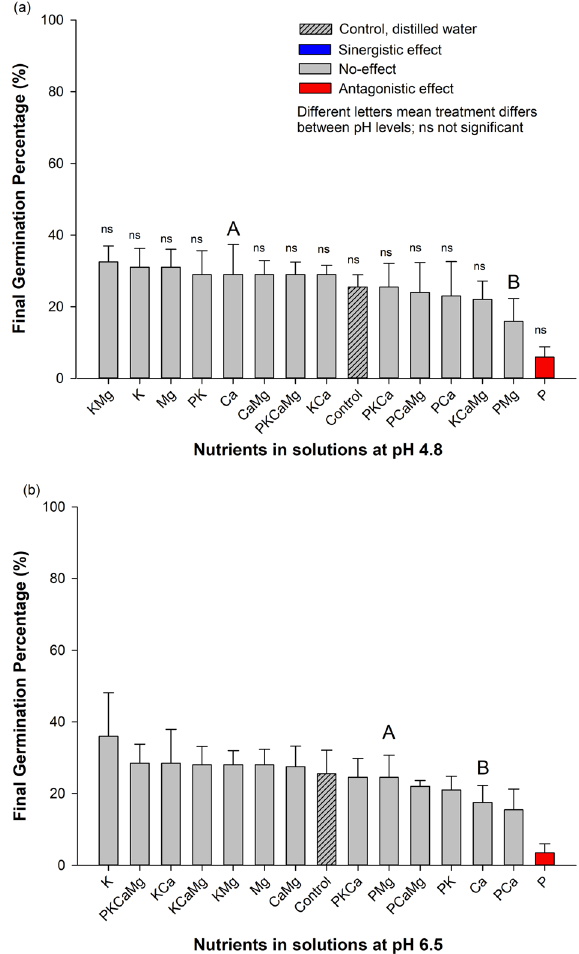
Figure 1. Final germination percentage (FGP) of Conyza canadensis in response to the nutrients (alone or in combination) under solutions at pH 4.8 ( a ) and at pH 6.5 ( b ). Bars with the different colours, comparing means among treatments, are significantly different, according to the Tukey’ test ( p < 0.05). Different letters represent a statistical difference for the same treatment between the two pH tested while ns represents not significant; The results in the Bars represent means, while error bar marks represent standard deviation ( n = 4) from the mean